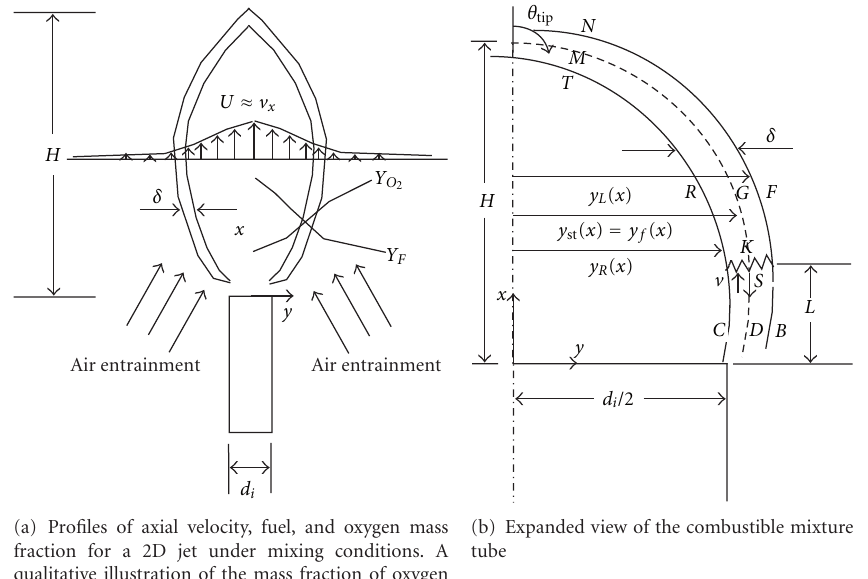
Figure 2: Profiles describing various aspects of the flame.